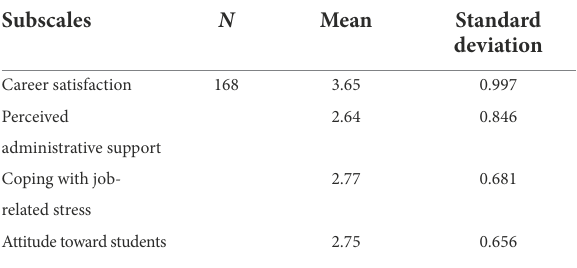
TABLE 1 Mean and standard deviation of the subscales of teacher burnout scale.